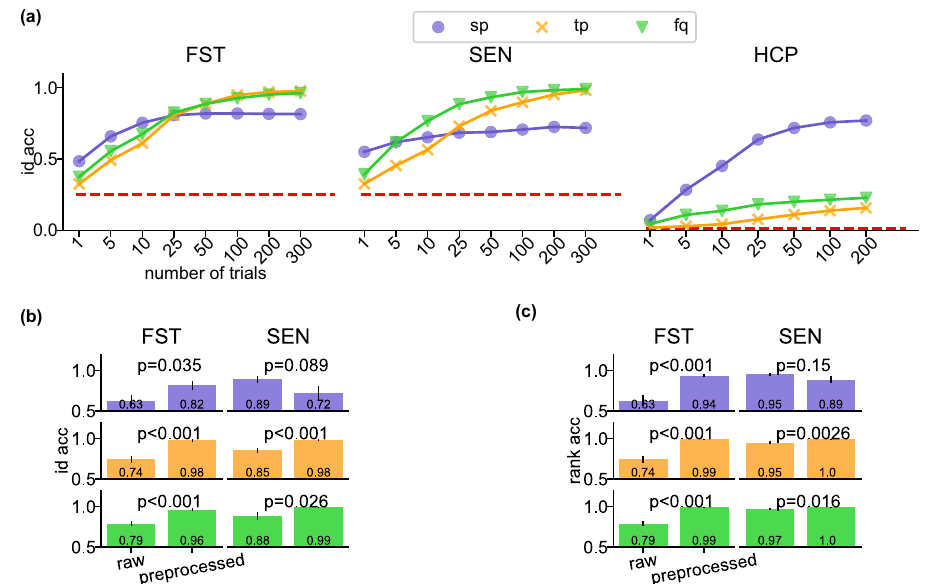
Fig. 8 Factors affecting identi fi cation accuracy. a Identi fi cation accuracy with respect to the number of trials (sample size) used for the featurization of FST, SEN, and HCP data. Each dot represents the identi fi cation accuracy averaged across individuals, identi fi cation runs, and cross-sessions (or cross-task sessions) excluding the within-session or within-task results. Error bars are the SEs across the corresponding cross-sessions (or cross-task sessions), individuals, and identi fi cation runs of each dataset and are invisible due to small values. b – c Identi fi cation ( b ) and rank ( c ) accuracy of the three features computed on raw and fully preprocessed FST and SEN data. The same color represents the same feature as in ( a ). For ( b ), the identi fi cation accuracy across sessions ( N = 12 for FST, N = 6 for SEN) and individuals ( N = 4) were averaged with respect to identi fi cation runs ( N = 100) and were put into one vector (of N = 48 entries for FST and 24 entries for SEN) for each feature and level of preprocessing. The heights of the bar plots are the mean of the corresponding vector. A two-sided unpaired t -test was performed on the vectors of the same feature and dataset between the raw and preprocessed data. The p -values for all pairs are less than 0.05, except for the sp feature for SEN. For ( c ), the rank accuracy were put into one vector in the same way as in ( b ). The heights of the bar plots are the mean of the corresponding vector and the error bars are its SE A two-sided unpaired t -test was performed on the vectors of the same feature and dataset between the raw and preprocessed data. The p-values for all pairs are less than 0.05, except for the sp feature for